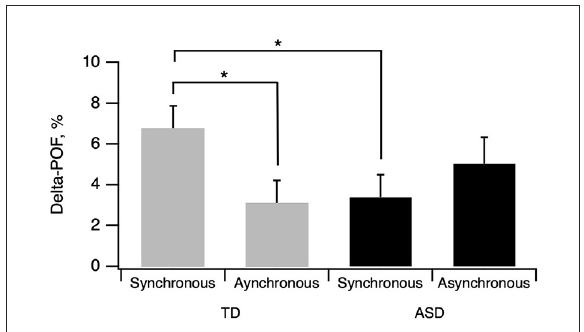
FIGURE3 Effect of Interpersonal multisensory stimulation. Delta-POF was calculated as mean POF in poststimulation condition minus mean POF in prestimulation condition. POF: Percentage of Other Face. Asterisks indicate significant